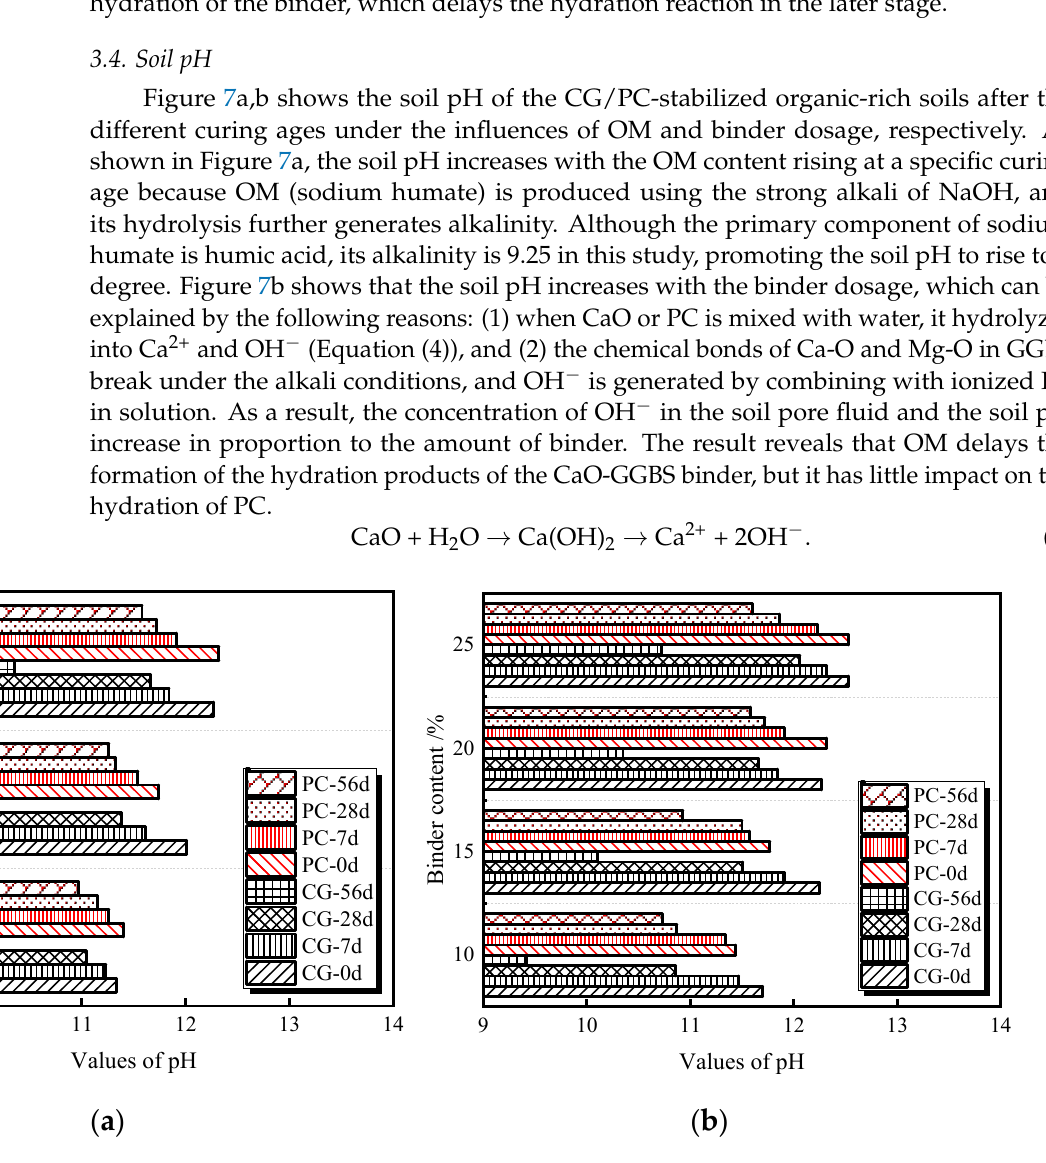
Figure 7. Soil pH of CG/PC-stabilized samples under different conditions. ( a ) Influence of organic content. ( b ) Influence of binder dosage.